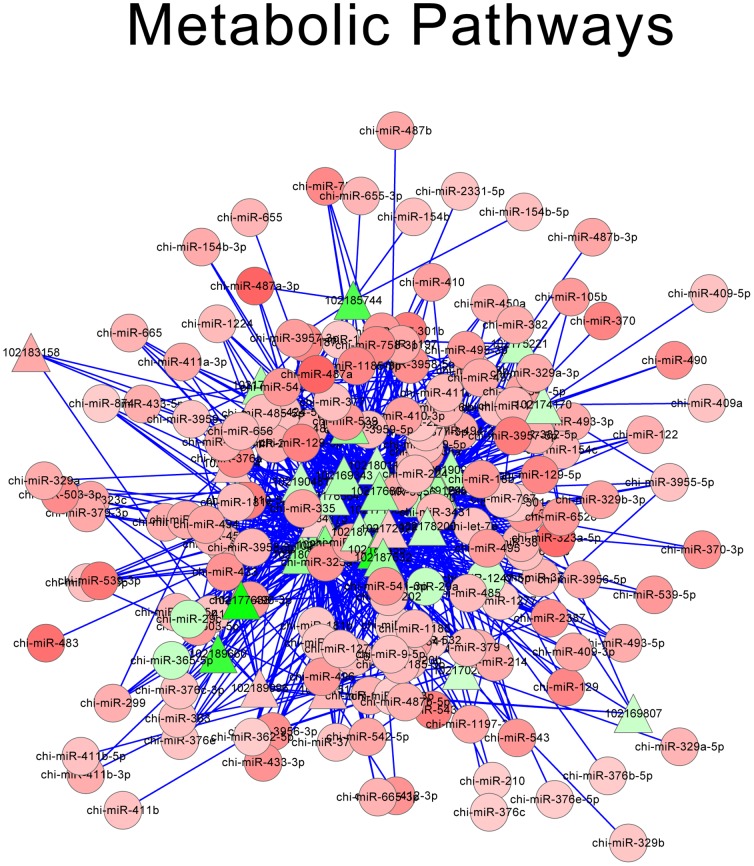
Network of metabolic pathways.Red triangle: up-regulated DE-targets; Green triangle: down-regulated DE-targets; Red roundness: up-regulated miRNAs; Green roundness: down-regulated miRNAs. The deeper the color, the stronger the trend.